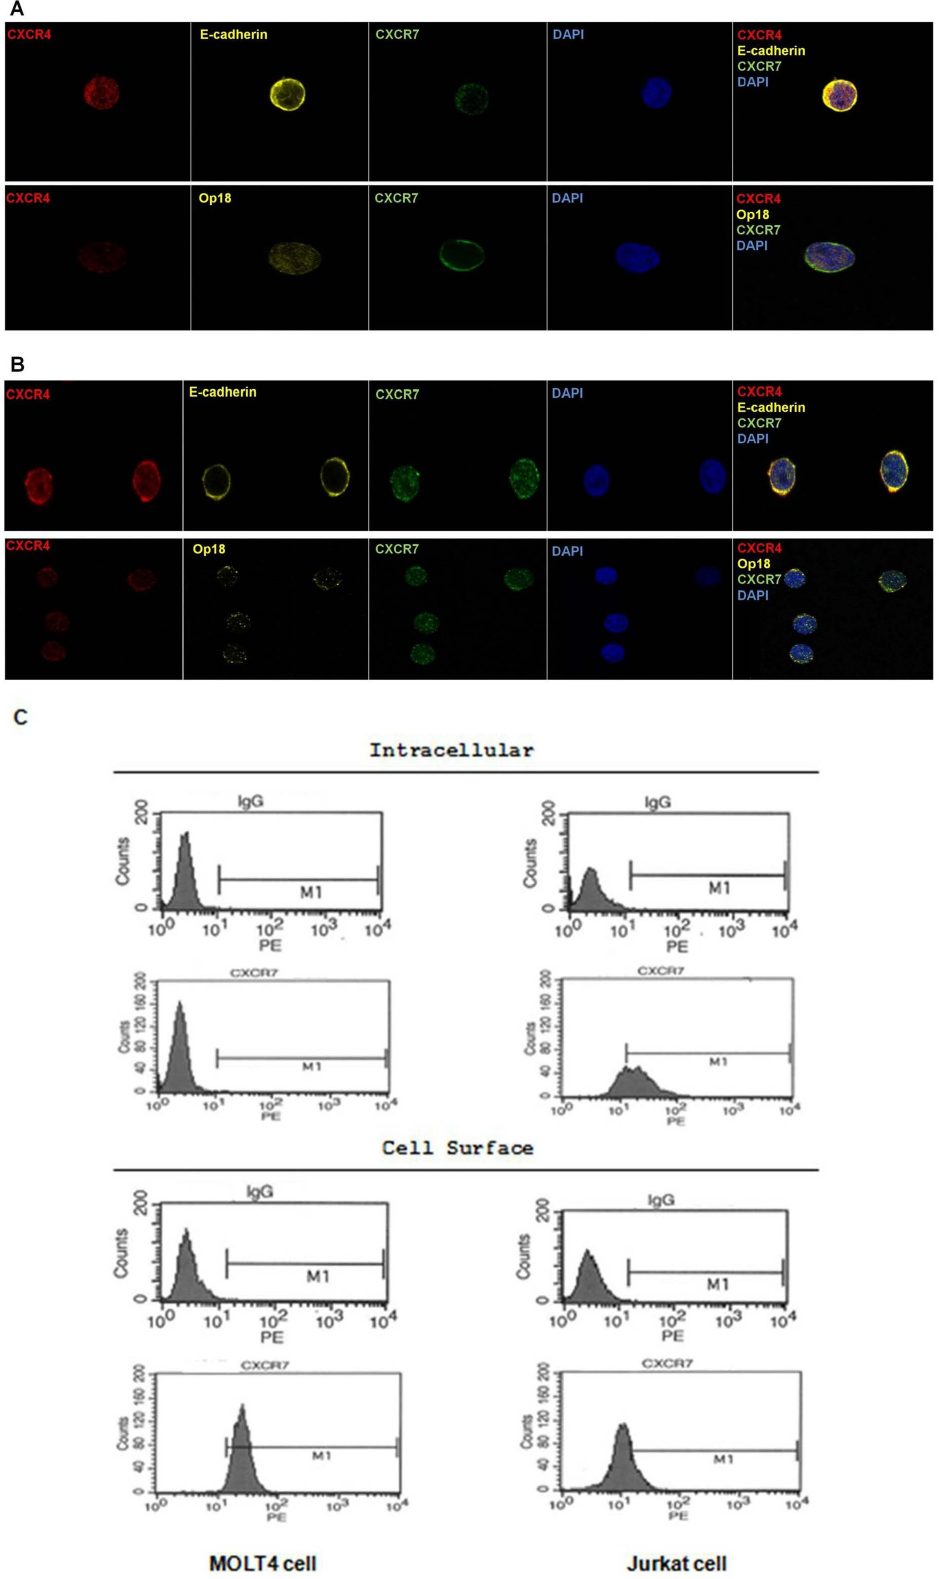
Figure 5. Different localizations of CXCR7 in MOLT4 cells and in Jurkat cells. CXCR4 has the same cellular localization (cell surface and intracellular) in both cell lines. (A–B) Confocal micrographs of MOLT4 and Jurkat cell lines displaying CXCR7 (green) and CXCR4 (red) staining using